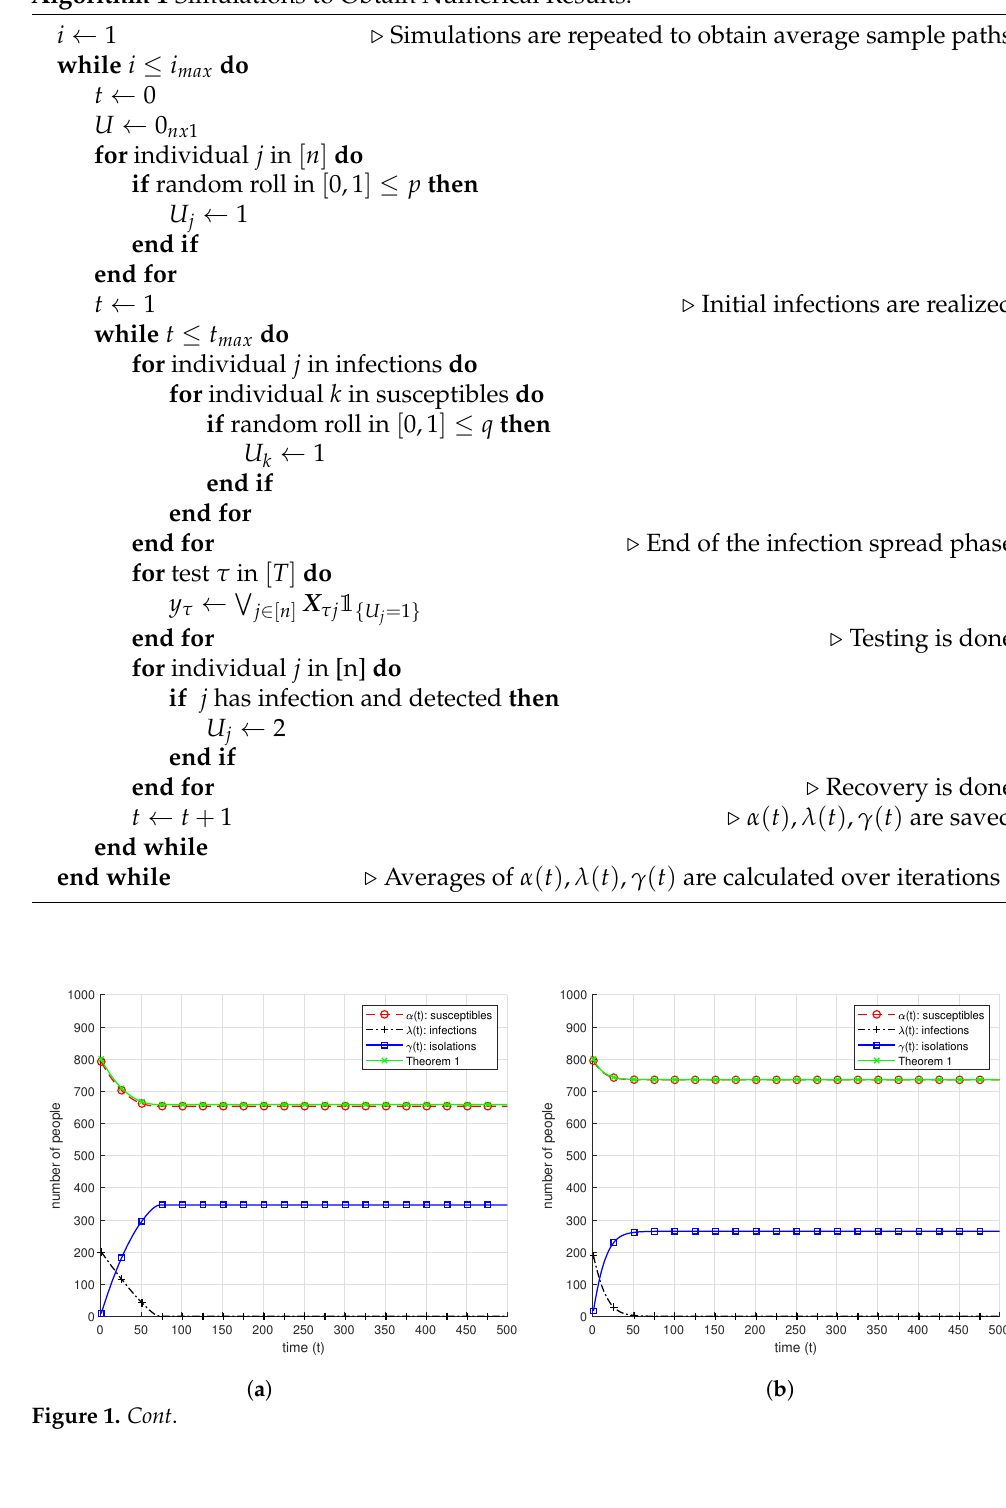
Algorithm 1 Simulations to Obtain Numerical Results.